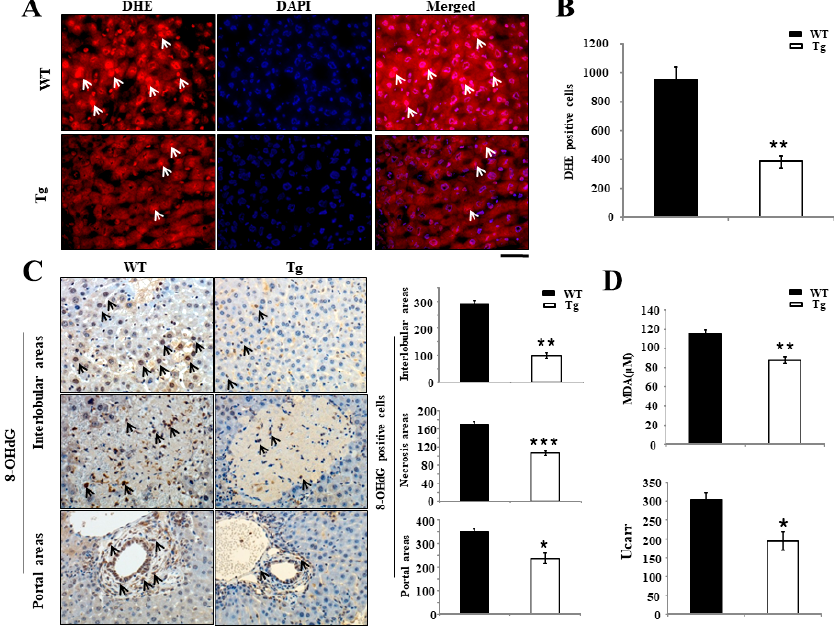
Figure 2. Hepatic oxidative stress in BDL-induced cholestatic liver of mice. ( A , B ) Dihydroethidium (DHE) staining indicates that the livers of hPRDX4-Tg mice contained significantly fewer DHE-positive hepatocytes than in WT mice at day 7 after BDL surgery. Arrows, positive cells. ( C ) Furthermore, 8-hydroxy-20-deoxyguanosine (8-OHdG) staining revealed significantly fewer numbers of accumulated 8-OHdG-positive hepatocytes in both the portal tract and interlobular areas in hPRDX4-Tg mice than in WT mice at day 7 after BDL surgery. Arrows, positive cells. ( D ) The levels of the oxidative stress markers thiobarbituric acid reactive substances (TBARS) and hydrogen peroxide (H 2 O 2 ) in PRDX4-Tg mice were significantly lower than in WT mice at day 7 after BDL surgery. p Values were calculated using Welch’s t -test. The values represent the mean ± SD. Bar = 100 µ m * p < 0.05, ** p < 0.001, *** p < 0.0001, n = 15.